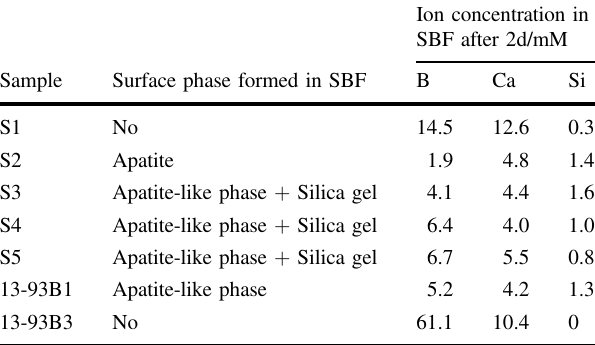
Ion concentration in SBF after